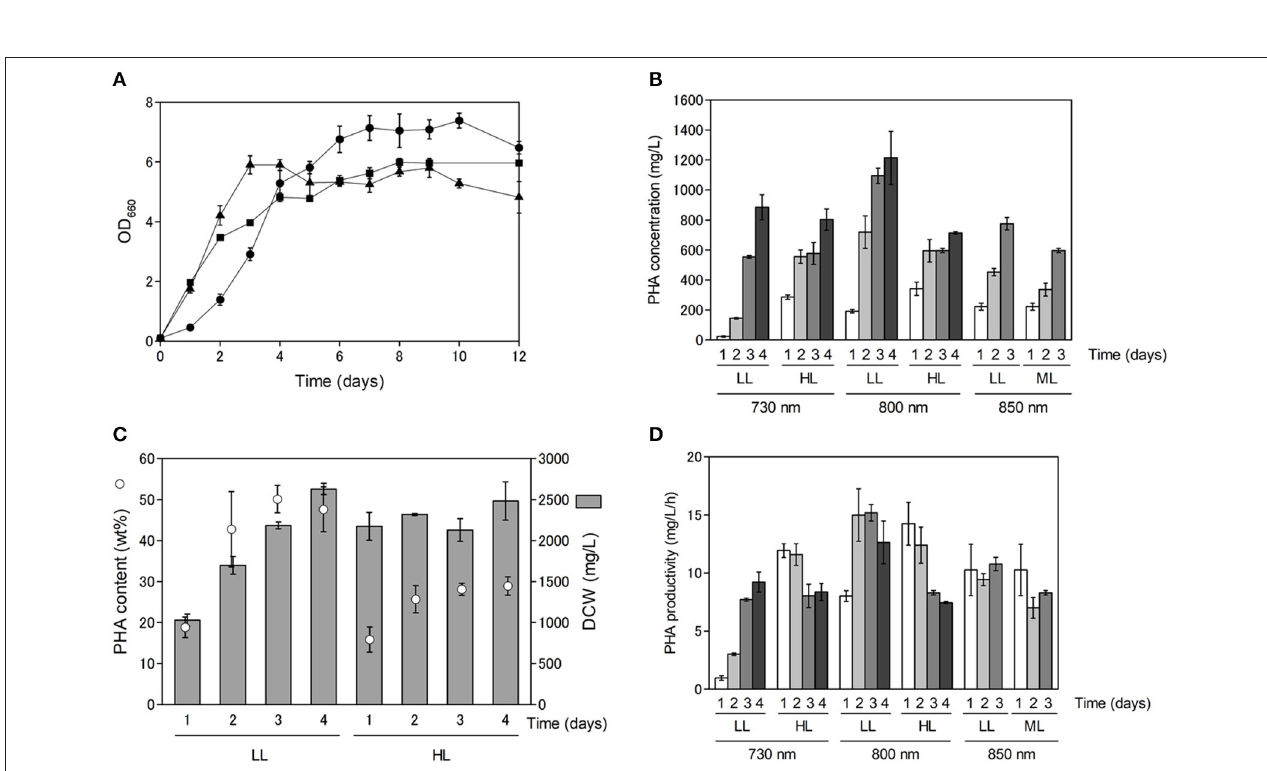
FIGURE 2 | Cell growth and PHA production under different light conditions. (A) Growth of marine purple non-sulfur bacteria under different light conditions. Cells were inoculated in growth medium to an OD 660 of 0.1 and cultured for 1 to 12 days under 8 W/m 2 of 730-nm (black circles), 800-nm (black triangles) and 850-nm (black squares) LEDs. Data are the mean ± SD of at least three cultures. (B) PHA concentrations (mg/L) under different light conditions. Cells were cultured under low-light (LL: 8 W/m 2 ), intermediate-light (ML: 20 W/m 2 , 850nm) and high-light (HL: 50 W/m 2 ) conditions. PHA concentrations were determined after 1 to 4 days of incubation. Data are the mean ± SD of at least three cultures. (C) Comparison between PHA content and DCW under 800-nm LED lighting. PHA content under low and high intensities of 800-nm LED light were plotted against DCWs. PHA contents and DCWs were determined after 1 to 4 days of incubation. (D) Time-course of PHA productivity (mg/L/h) under different light conditions. PHA productivities were determined after 1 to 4 days of incubation.